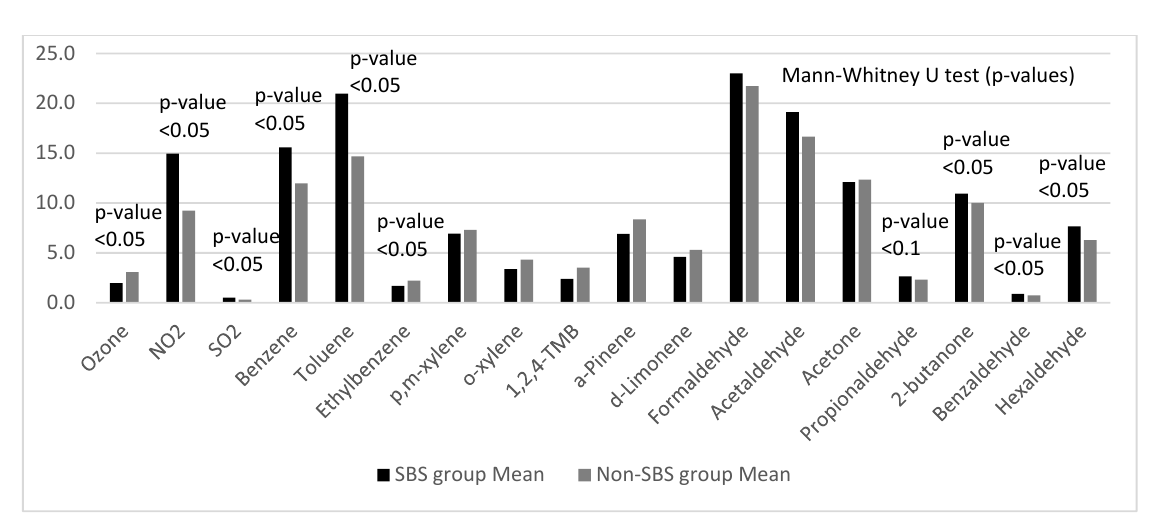
Figure 12. Differences in indoor concentrations (μg/m 3 ) between SBS and non-SBS group. As a next step and for exploring indoor concentration variations in greater depth, tests were performed for each SBS symptom subgroup (Table 5). For occupants who reported eye irritation, NO 2 ( p < 0.1), benzene and toluene, benzaldehyde and hexaldehyde ( p < 0.05), concentrations were higher in their offices than in those of occupants without symptoms. In offices where occupants with reported respiratory symptoms, NO 2 and toluene ( p < 0.05), 2-butanone ( p < 0.05) were also measured in higher levels. For the heart and skin symptoms groups, fewer compounds were revealed to be significantly higher (NO 2 , Hexaldehyde ( p < 0.05) and toluene ( p < 0.1), respectively). For offices where occu- pants reported general symptoms, mean concentration values of NO 2 , benzene and hex- aldehyde ( p < 0.05) were found in higher concentrations. Table 5. Differences in indoor concentrations (μg/m 3 ) between SBS and non-SBS among symptom subgroups. Symptoms Group